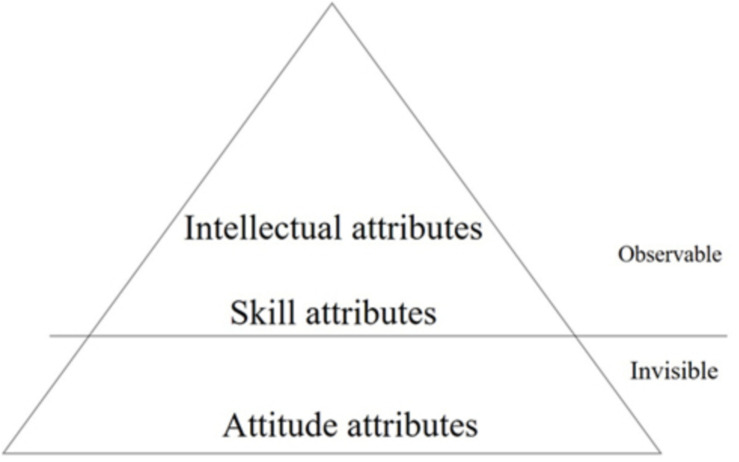
Competency model.